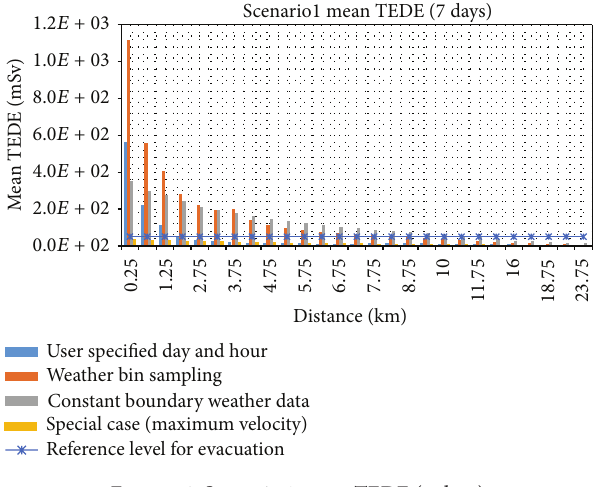
Figure 4: Scenario 1 mean TEDE (7 days).